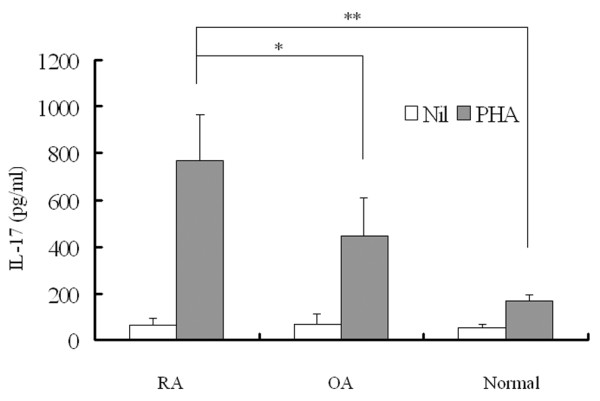
Levels of interleukin (IL)-17 production in peripheral blood mononuclear cells from patients with rheumatoid arthritis (RA; n = 24), patients with osteoarthritis (OA) (n = 14) and normal individuals (n = 14). Each peripheral blood mononuclear cell was stimulated for 24 hours with or without phytohemagglutinin (PHA; 5 μg/ml). IL-17 was measured in culture supernatants by sandwich enzyme-linked immunosorbent assay. Data are expressed as means and SEM. One representative result of five independent experiments is shown. Student's t-test was used to compare each group. *, P < 0.05; **, P < 0.001.